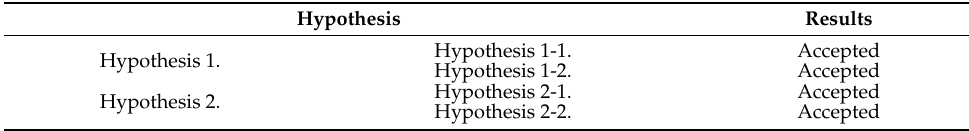
Table 11. The results of the hypothesis